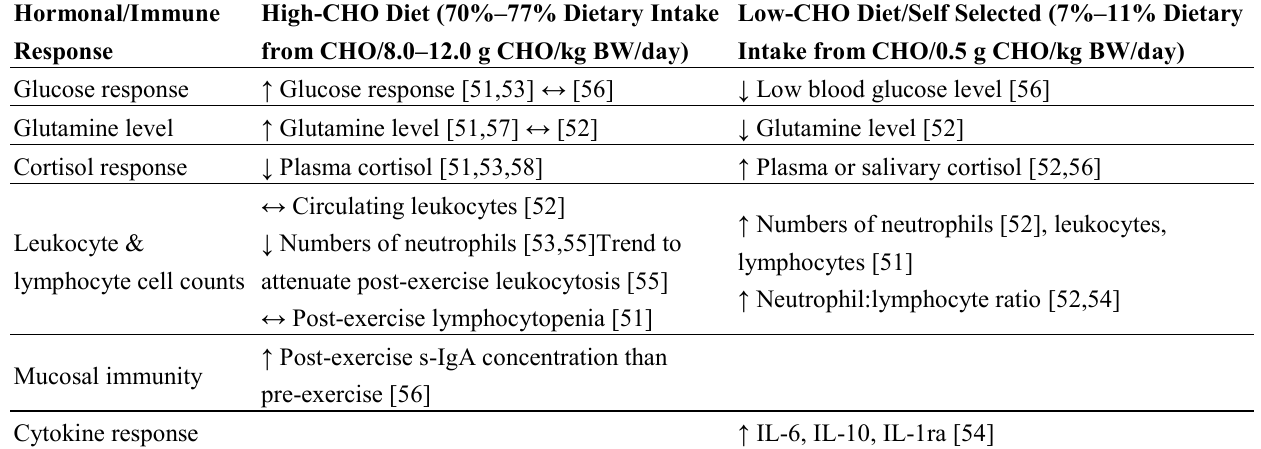
Table 1. Effects of pre-exercise high- vs . low-CHO diet on hormonal & immune response to endurance exercise (↑: increase; ↓: decrease; ↔: no effect; CHO: carbohydrate; BW: bodyweight; /day: per